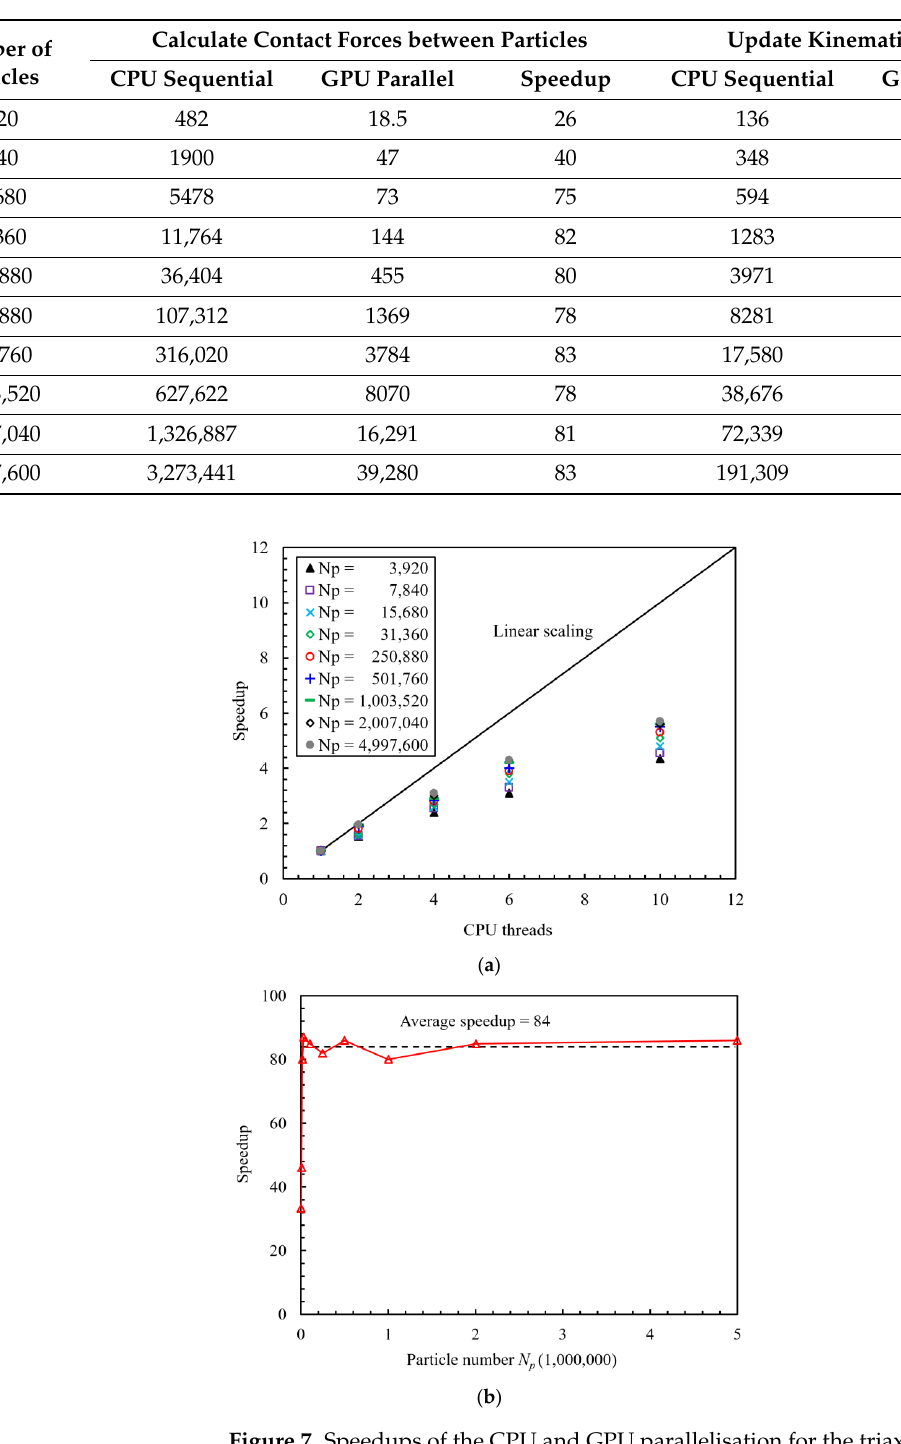
Table 2. Speedups of GPU parallel calculations for the procedures in triaxial test cases.